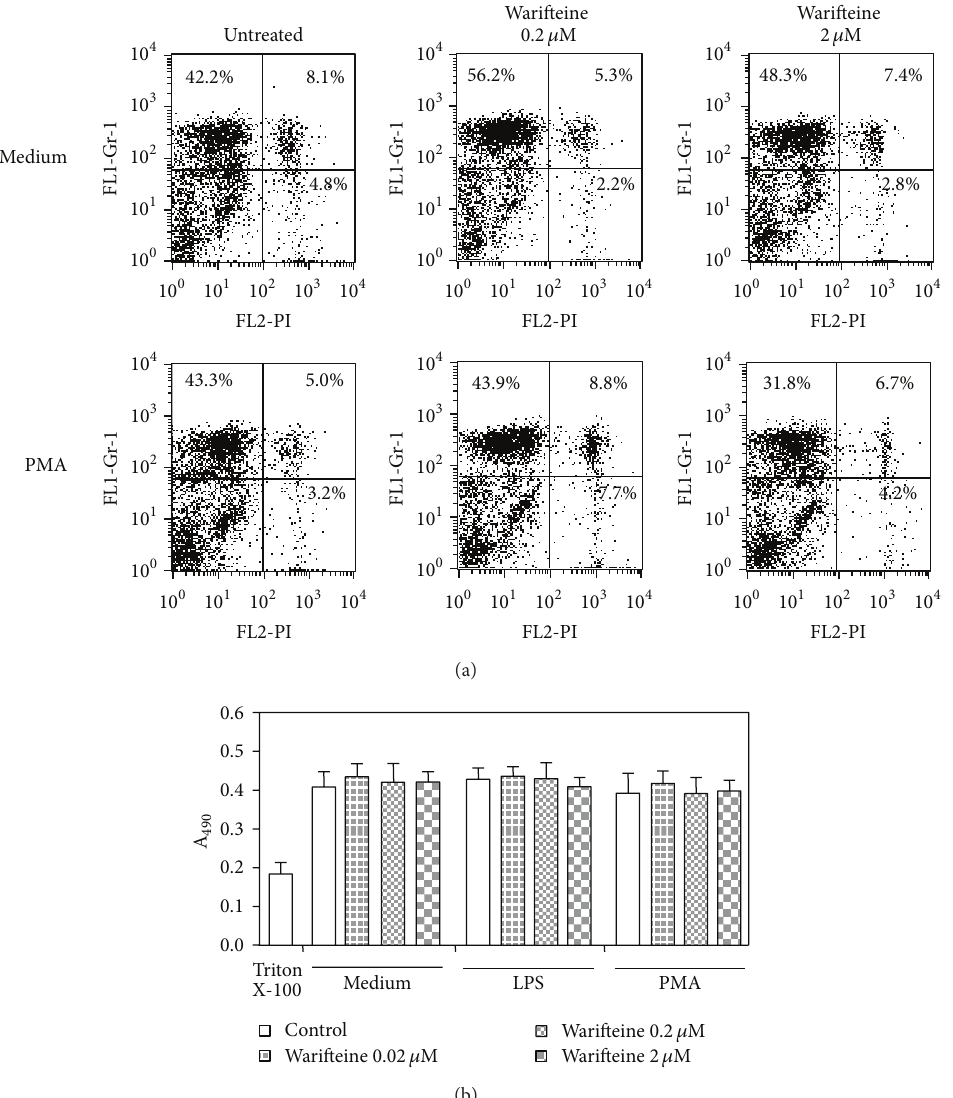
Figure 3: Evaluation of the toxic effect of warifteine on neutrophils. (a) Isolated neutrophil suspensions were incubated with the indicated doses of warifteine and subsequently stimulated with PMA. Cultures were then incubated with FITC-labeled anti-Gr-1 antibody, which was followed by incubation with a solution of propidium iodide. The samples were analyzed for propidium iodide labeling by flow cytometry. The plots indicate the labeling of cells in the PMN gate (as defined in Figure 2) and are representative of two independent experiments. (b) Isolated neutrophil suspensions were treated for 90 min with PMA. Some cultures also received the indicated doses of warifteine. The cells were then incubated with the XTT dye and XTT reduction by viable cells was determined. Triton X-100-treated cultures were used as positive (dead cells) controls. Statistical analysis showed no significant differences between warifteine-treated and untreated groups. Data are representative of three independent